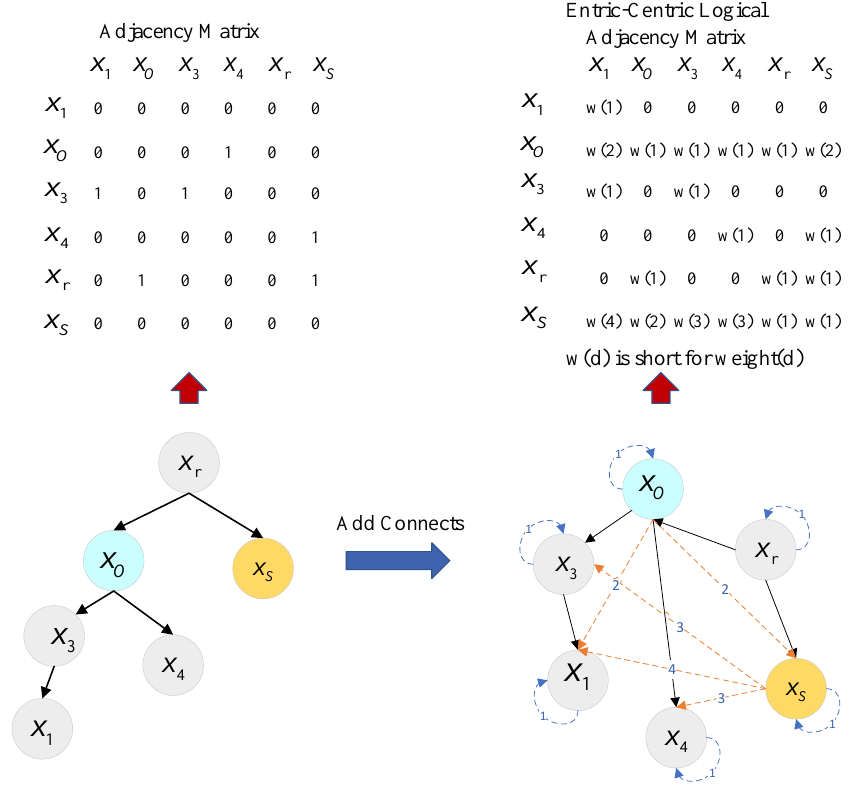
Figure 4. Construction process of the entity-centric logical adjacency matrix. The dashed lines represent the new connections between the entity nodes and the other established nodes, and the dashed line represents the self-loops of the nodes themselves. The number on the line represents the distance between the nodes. w () is short for weight () function. The nodes of x O and x S represent the subject entity and object entity,